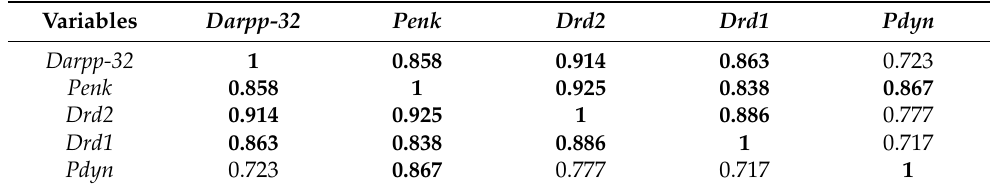
Table 4. Pearson pairwise correlation coefficients of key DS-specific genes’ expression profiles across samples (df =